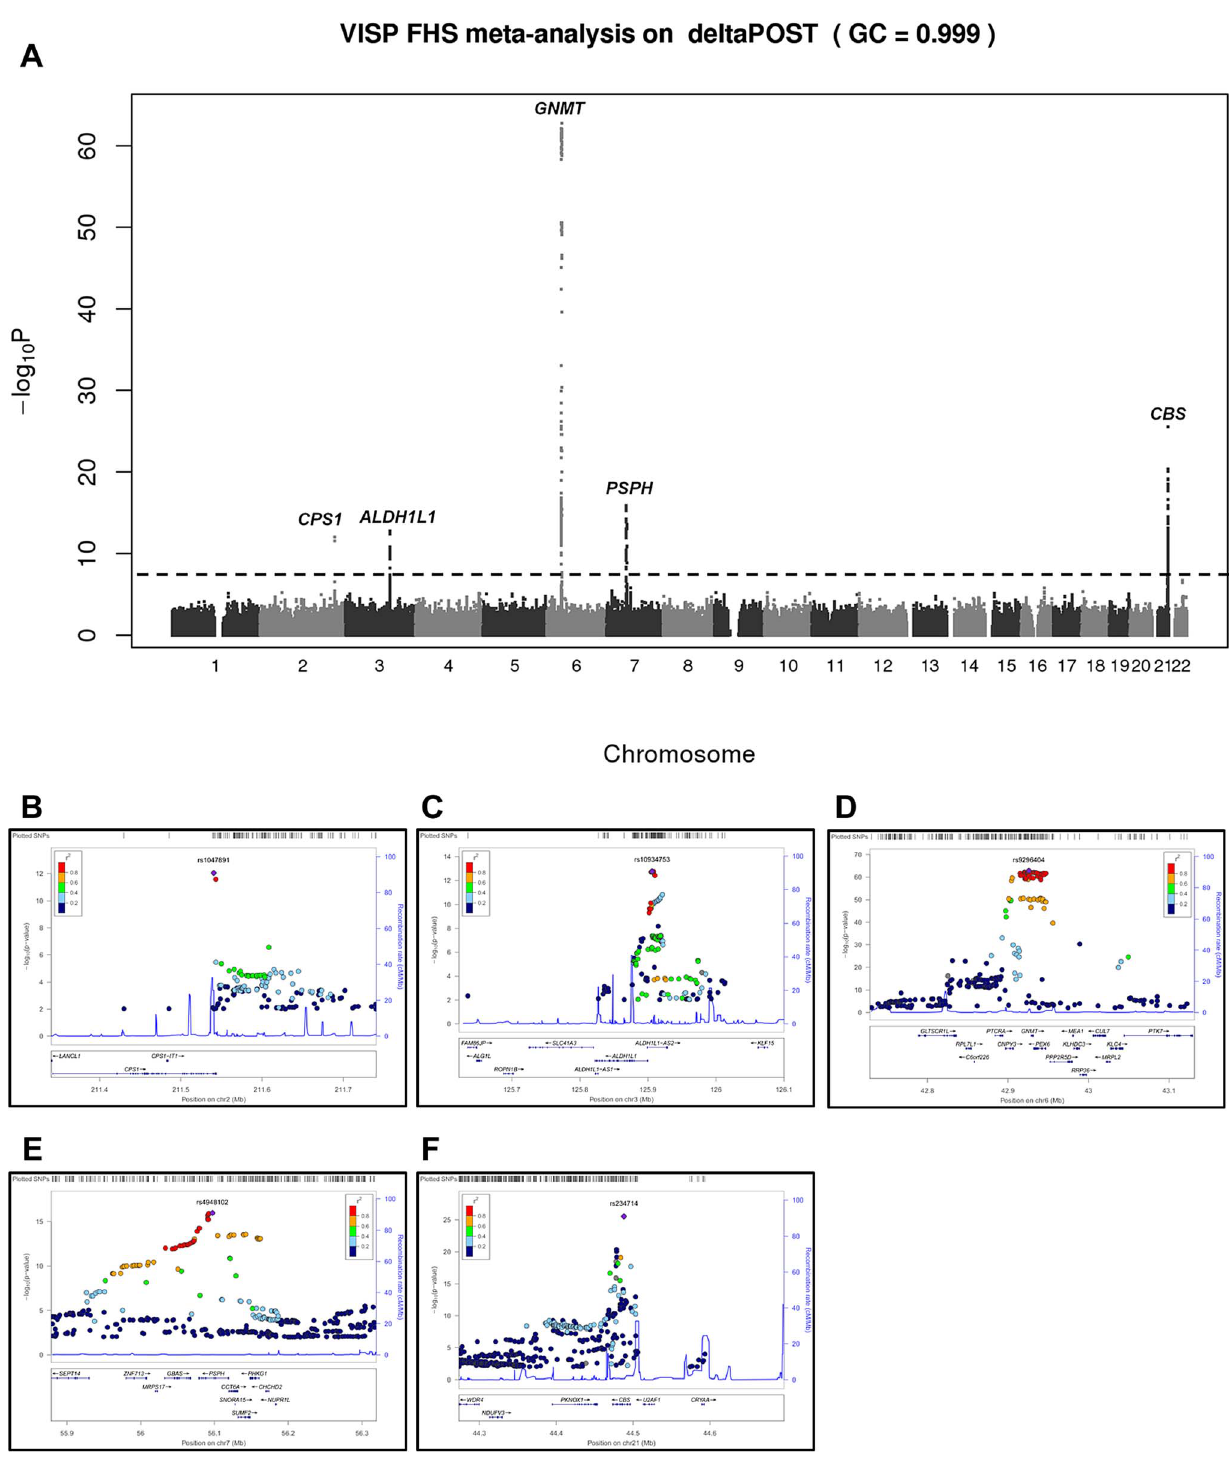
Figure 1. Meta-analysis and chromosome 2, 3, 6, 7 and 21 regional association of single nucleotide polymorphisms (SNPs) for D POST in both VISP and FHS cohorts. A sample size-weighted meta-analysis was used. (A) Manhattan plot of meta-analysis association results for the combined VISP and FHS samples. Association p-values are noted on the Y axis (-log 10 P value), with points above the dashed line indicating SNPs reaching or exceeding genome-wide significance (P # 5 6 10 2 8 ). (B–F) Locus Zoom plots showing the regional association of chromosomes 2, 3, 6, 7 and 21. Y-axis shows –log 10 p-value # 0.01. X-axis shows Mb position on each chromosome. Each circle represents an independent SNP and color shading represents r 2